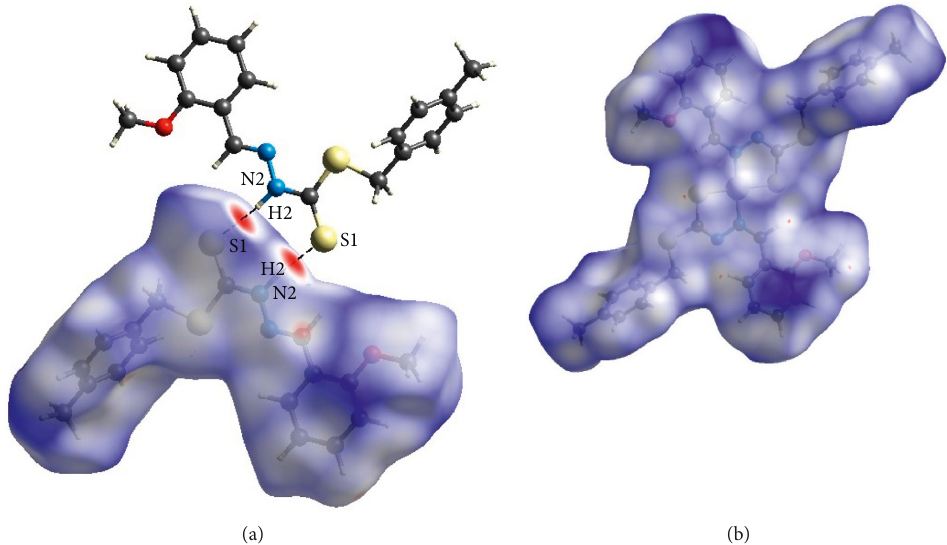
Figure 6: Hirshfeld surface mapped over d